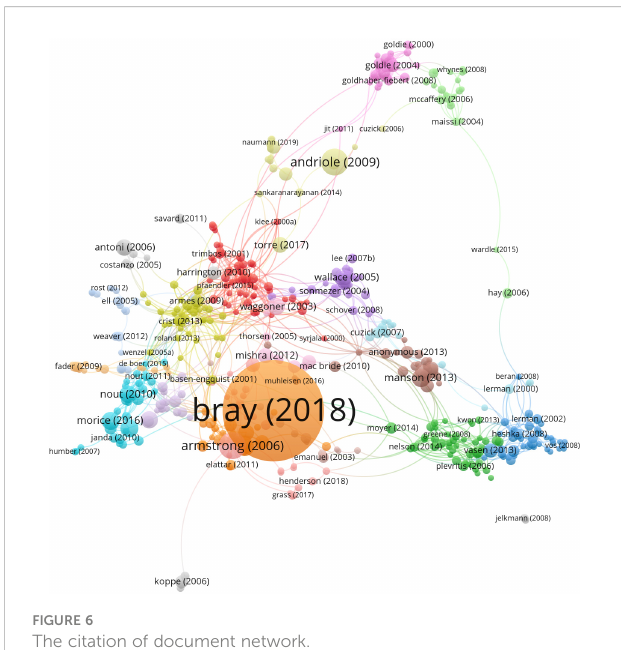
FIGURE 6 The citation of document network.